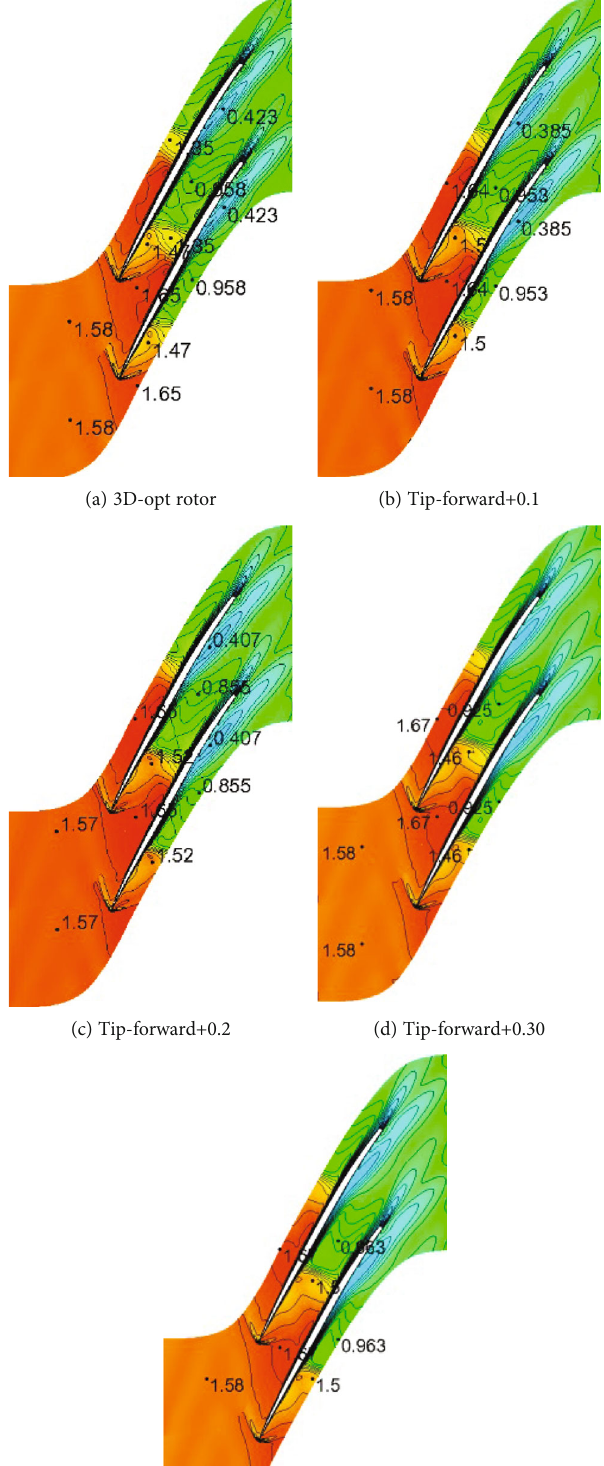
Figure 24: Mach number contours at 90% span of the fi ve rotors at working point